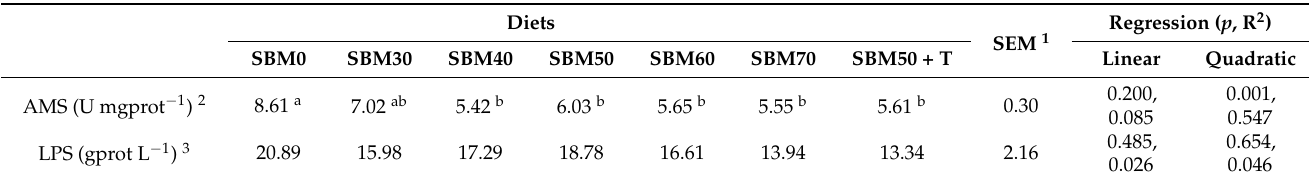
Table 10. Digestive enzyme activity in the intestine of juvenile Oplegnathus punctatus fed experimental diets for eight